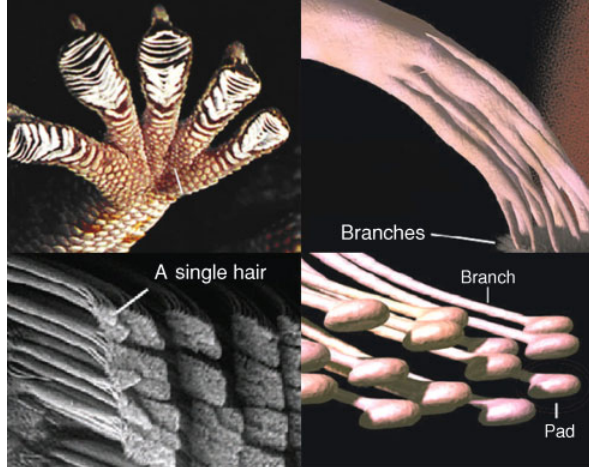
Figure 1 The structure of a gecko’s